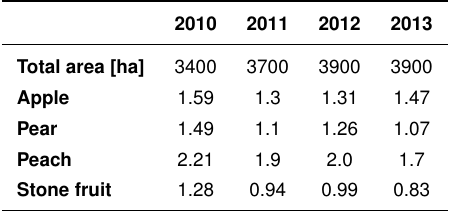
Table 7. Average copper application rates [pure copper kg ha − 1 ] in organic fruit-growing in 2010 to 2013.